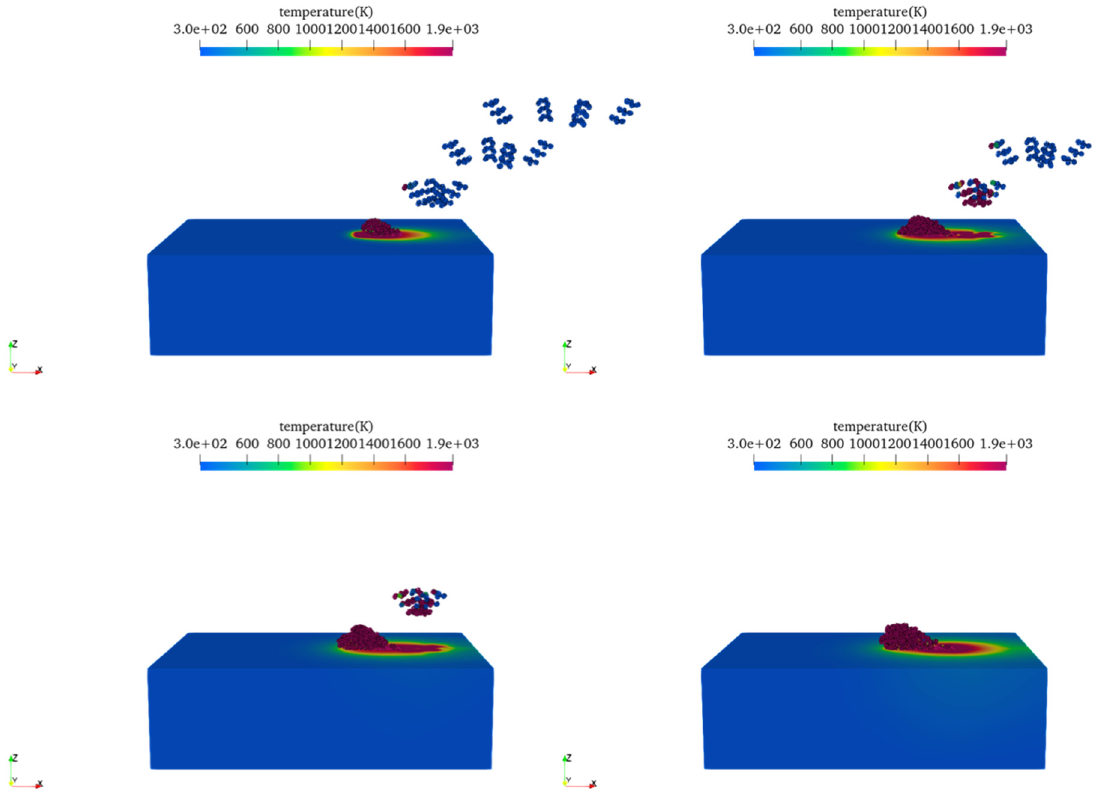
Figure 13. The temperature field distribution in the four-layer cladding process. Figure 14. The simulated cladding layers by HOTM : ( a ) ‐ ( d ) represent the solidified material by 1,2,3,4 printing, respectively.